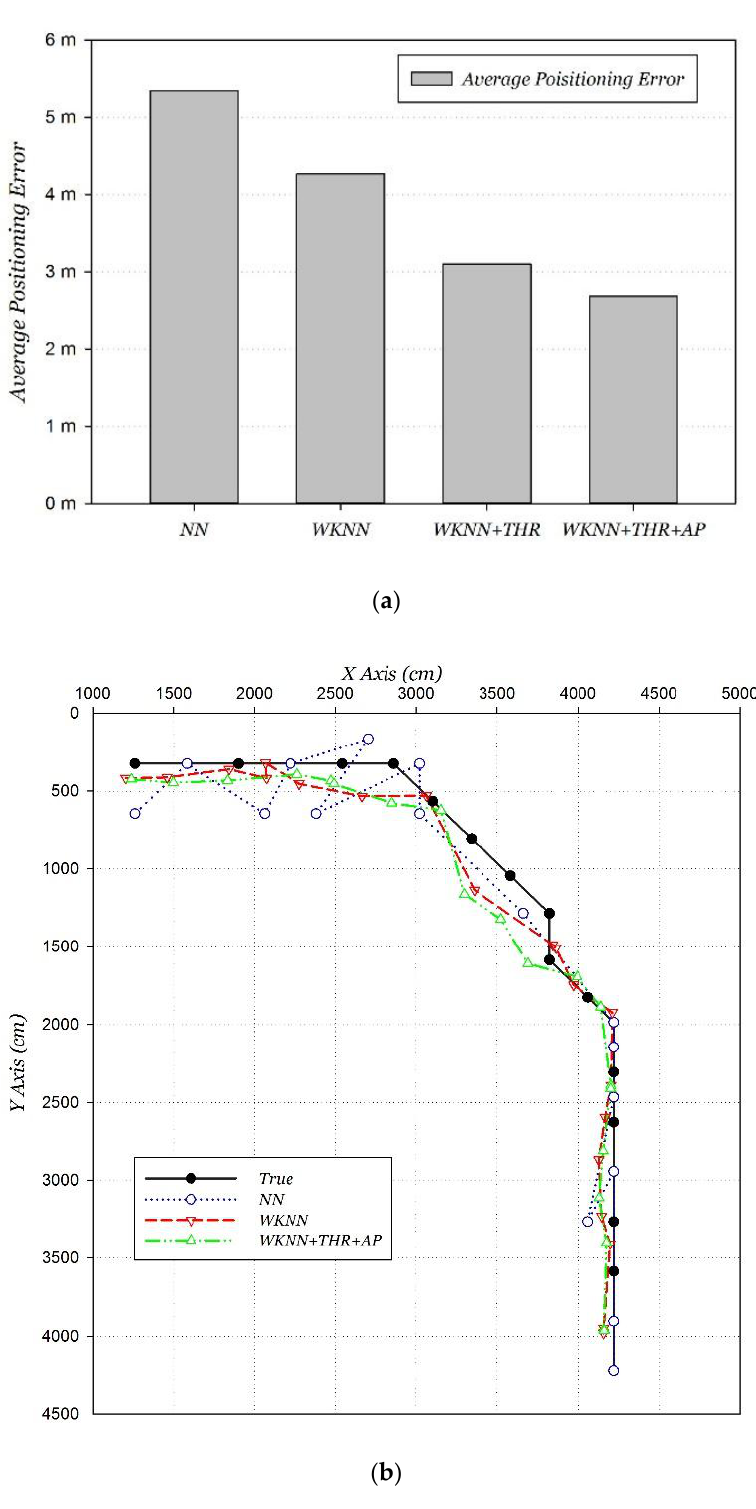
Figure 14. Performance of improved Wi-Fi positioning. ( a ) Accuracy; ( b ) distribution.